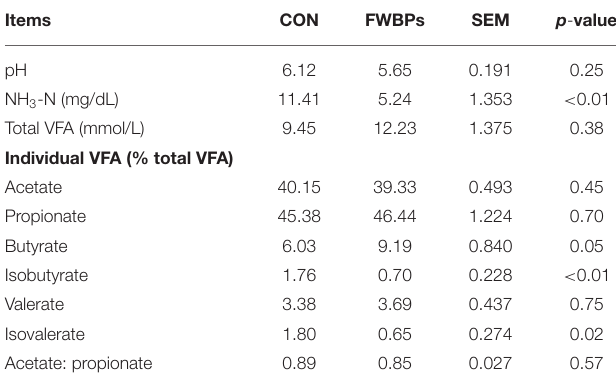
TABLE 6 | Effects of FWBPs on the ruminal fermentation parameters of early weaned